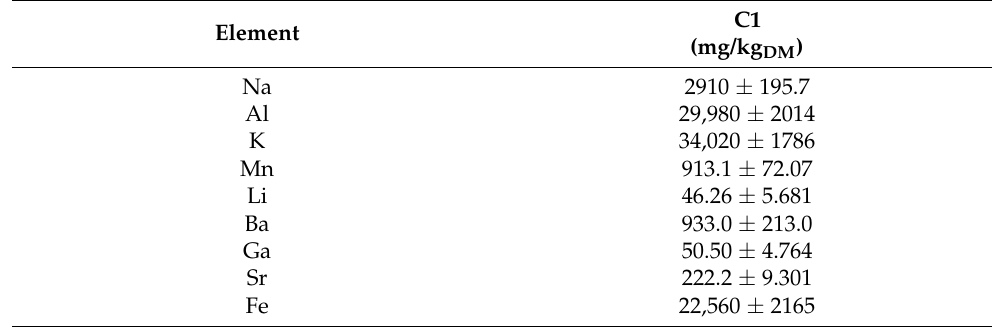
Table 2. Concentrations ± standard deviations of different minor and trace elements in the non-